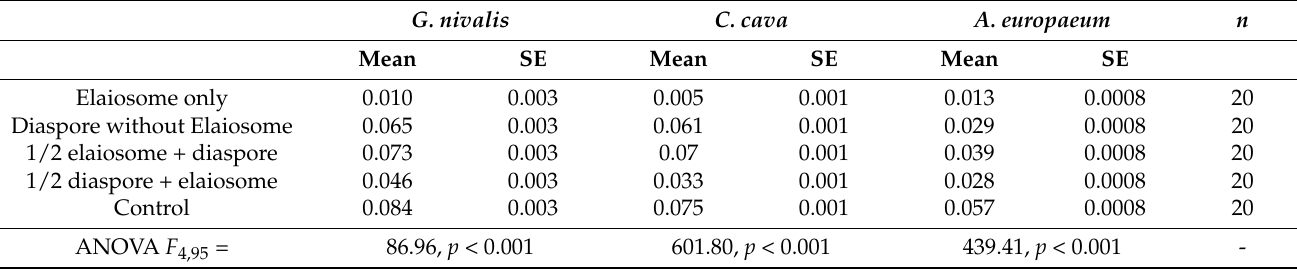
Table 1. Descriptive comparison of diaspores/elaiosomes among five treatments. Mean represents the mean wet weight of six diaspores/elaiosomes (g). Mean and standard error (SE) are provided.